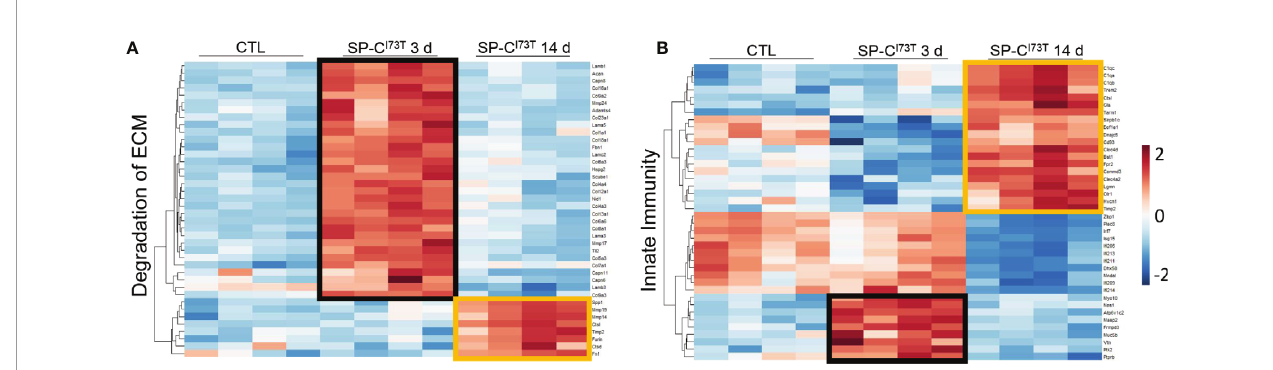
FIGURE 1 | Extracellular matrix and innate immunity expression analysis of fl ow cytometry sorted CD11b + Ly6C hi monocytes following SP-C I73T induced injury. Differentially expressed genes (fold change > 1.5 and false discovery rate [q-value] < 0.05) were analyzed using Reactome database to highlight enriched signaling pathways. N = 4 was utilized in each study condition. (A) Heat-map showing expression of signi fi cantly regulated genes involved in ‘ Degradation of Extracellular Matrix (ECM) ’ . (B) Heat-map showing expression of signi fi cantly regulated genes involved in ‘ Innate Immunity ’ . Note black boxes represent genes uniquely expressed 3 d after SP-C I73T injury; orange boxes represent genes uniquely expressed 14 d after SP-C I73T